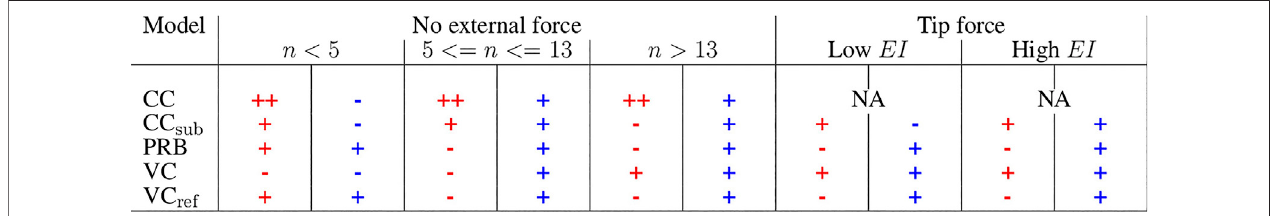
table but reversing the accuracy ” + ” and ” − ” signs of the column n < 5. NA: Not